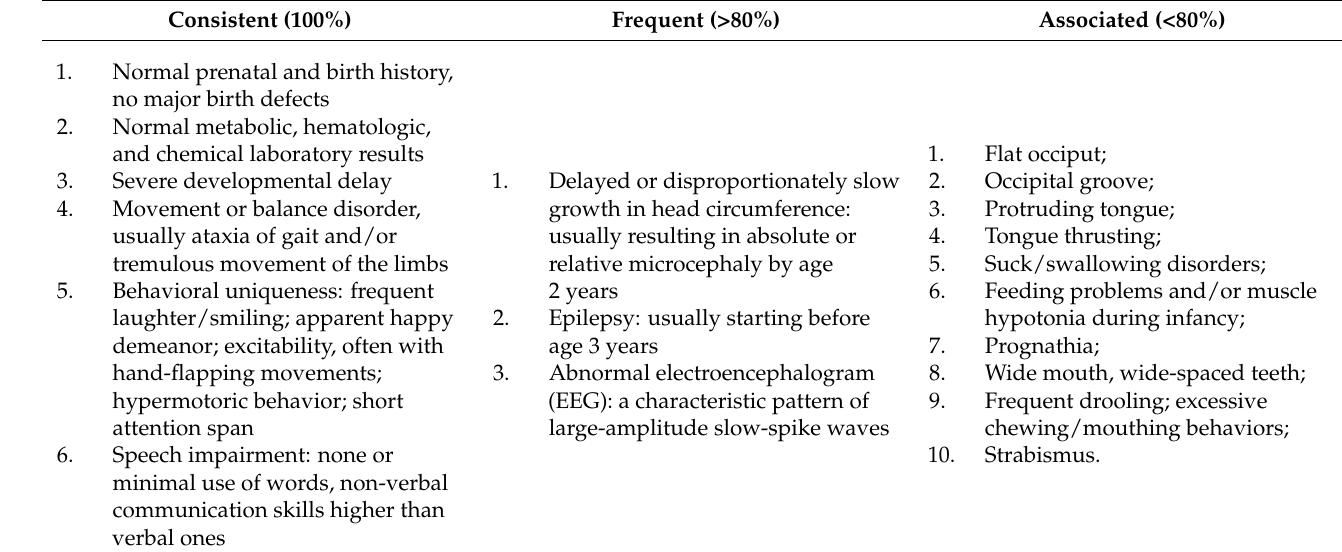
Table 1. Clinical characteristics of Angelman syndrome (adapted from Williams et al.